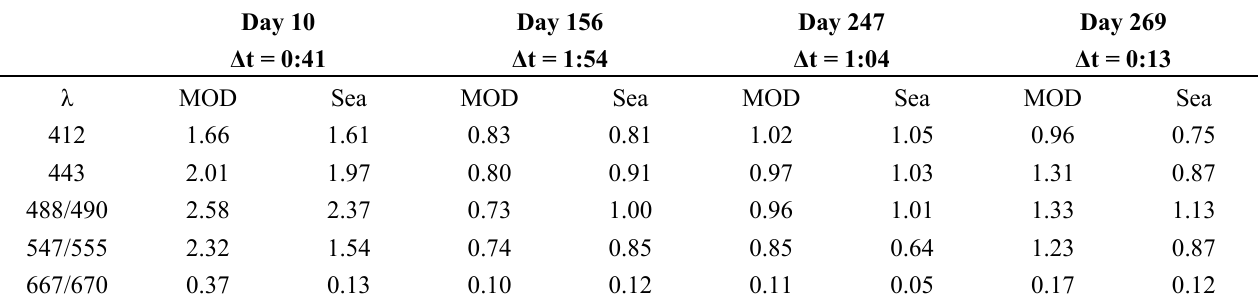
Table 5. L retrievals for samples where modmin and modmax (size fraction) are equal n w for MODIS and SeaWiFS ( λ / λ denotes MODIS/SeaWiFS wavelengths, Δ t denotes time i j difference between MODIS and SeaWiFS